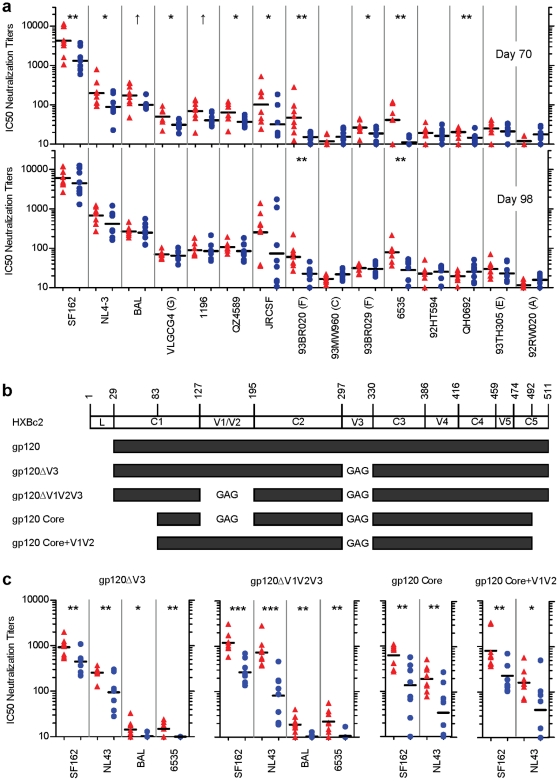
Characterization of the neutralizing antibody responses induced by ST-008.For (a) and (c), 8 rabbits were immunized with 3 DNA electroporations followed by one protein boost. Sera were evaluated for neutralizing activities against a panel of HIV-1 pseudoviruses. Neutralizing titers (IC50) by ST-008 and JRCSF immunogens are indicated by solid red triangles and blue solid circles, respectively. The geometric mean titer for each group is shown as black horizontal bar. The viruses are presented from left to right in increasing resistance to neutralization to N16 (see Table 2). *** P<0.001; ** P<0.01; * P<0.05; ↑ P<0.10 (see P values in Table 2 and Table S3). (a) Comparison between ST-008 and JRCSF gp120. Rabbits were boosted with JRCSF gp120. Day 70, after 3 DNA injections; Day 98, after protein boost. The subtype of each non-B virus is indicated in parentheses. (b) Schematic representation gp120 deletion constructs used in (c). (c) Comparison of 4 pairs of gp120 deletion constructs made from ST-008 and JRCSF. Rabbits were boosted with homologous proteins. Results of Day 98 sera are shown.